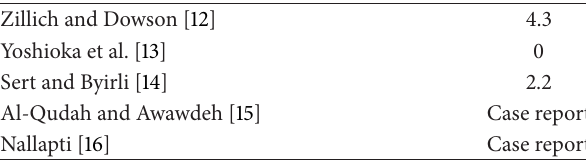
Table 1: Trifurcated canals for the mandibular first premolar (%).